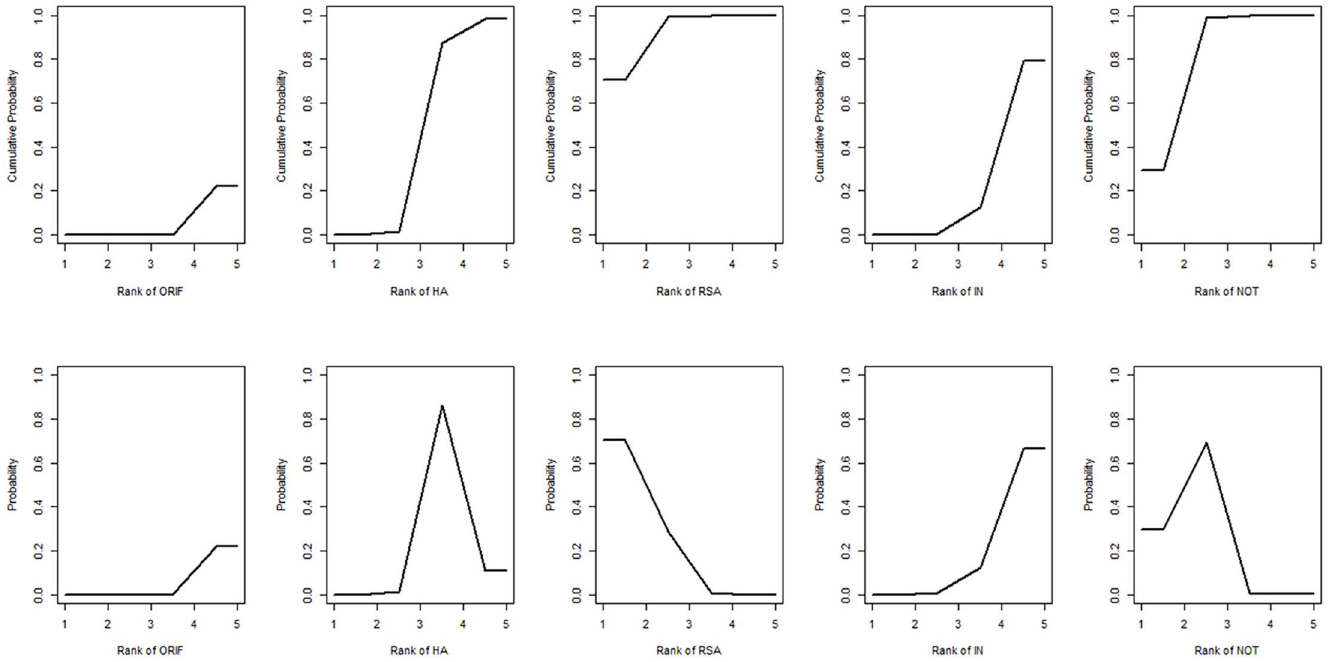
Fig 6. Ranking of treatment strategies based on the probability of their effects on the outcome of incidence of total complications. ORIF: open reduction and internalfixation; HA: hemiarthroplasty; RSA: reverse shoulderarthroplasty; IN: intramedullary nailing;NOT: Non-operative